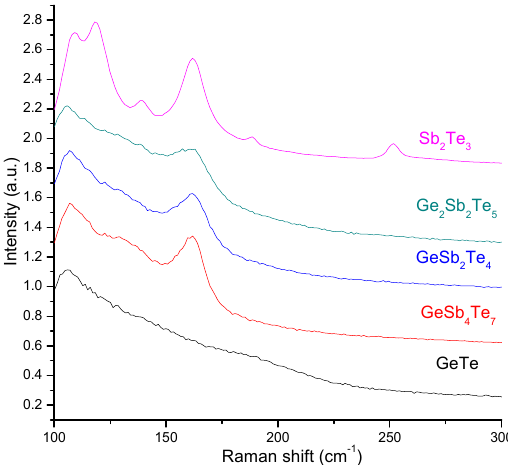
Figure 3. The Raman spectra of the five thin films deposited by ns-PLD at 266 nm (see Table 1 for deposition conditions).